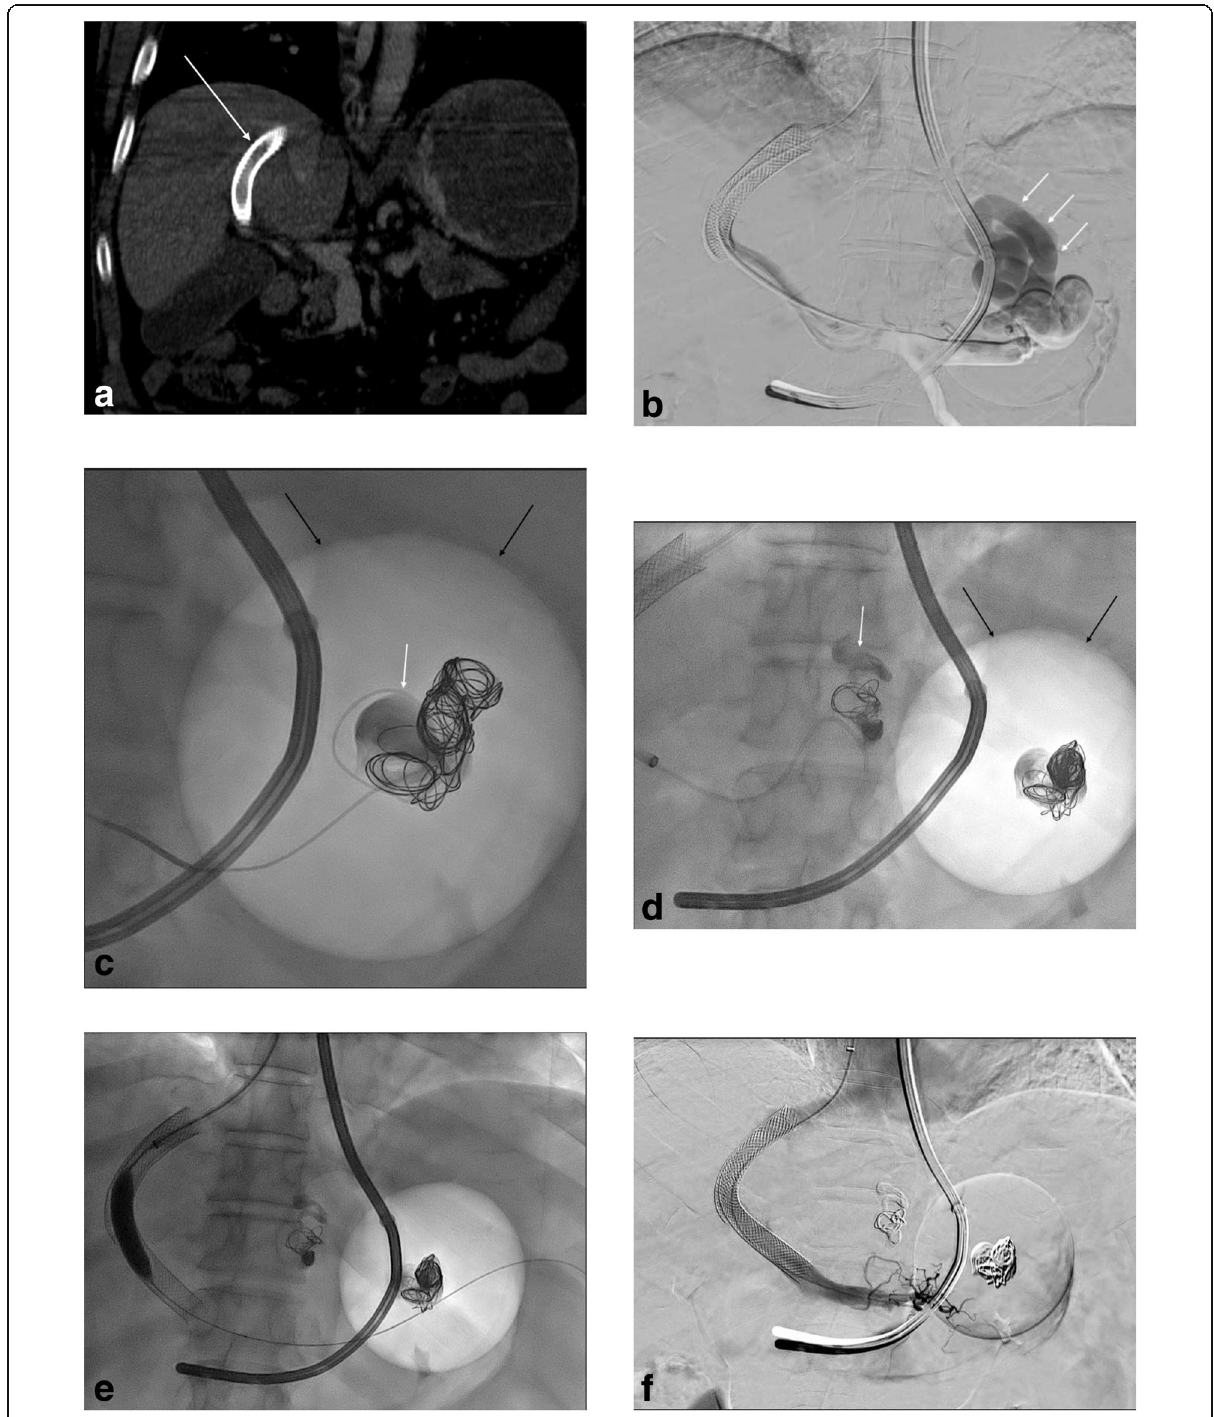
Fig. 1 a Contrast-enhanced computed tomography in emergency in a cirrhotic patient with haematemesis shows an occluded transjugular intrahepatic portosystemic shunt (TIPS) (white arrow). b Portography after TIPS recanalisation shows large gastric varices (white arrows). c Embolisation with an ethylene-vinyl alcohol (EVOH) liquid embolic agent (white arrow) and detachable coils of the gastric varices through a coaxial microcatheter. A Blakemore tube with inflated balloon in the stomach is evident (black arrows). d After gastric varices embolisation in the projective correspondence of the Blakemore tube (black arrows), also oesophageal varices were embolised with liquid embolic agent (white arrow) and detachable coils. e After gastroesophageal varices embolisation and an overlapped second stent placement, TIPS recanalisation was completed with high-pressure balloon angioplasty. f Final portography shows a quick opacification of the TIPS and the right atrium as good function of the portosystemic shunt without more evidence of the gastroesophageal